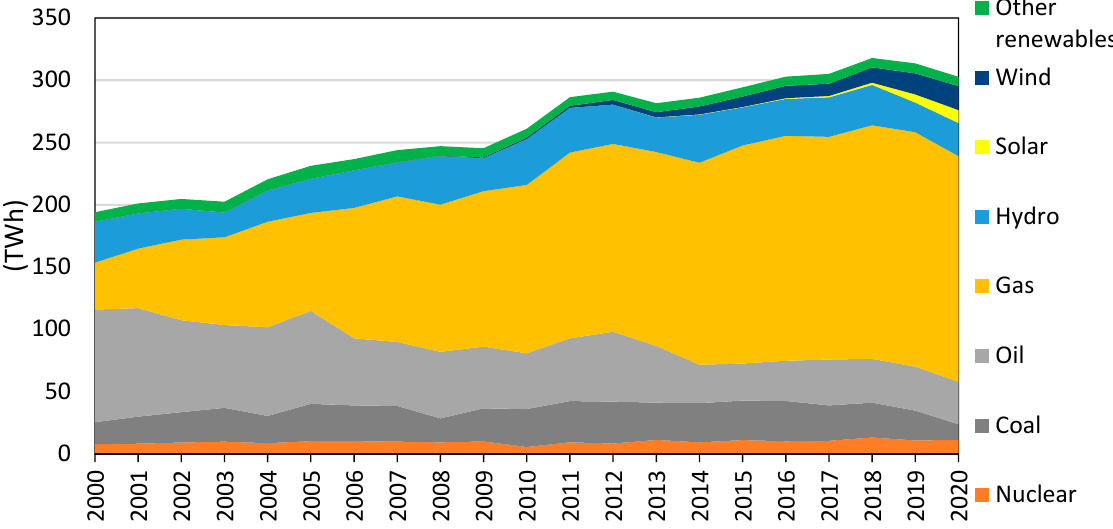
Figure 1. Electricity production in the Mexican power system by source in the period 2000–2020.